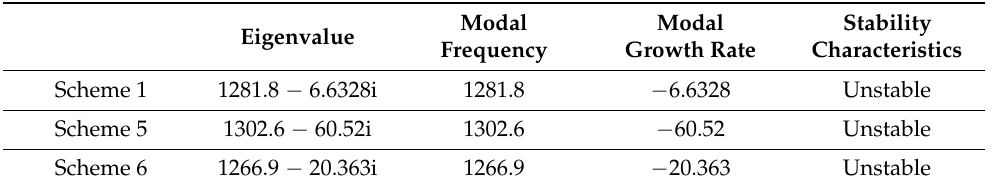
Table 7. Frequency and stability of the first-order longitudinal, zero-order tangential, zero-order radial modes for Schemes 1, 5, and 6.